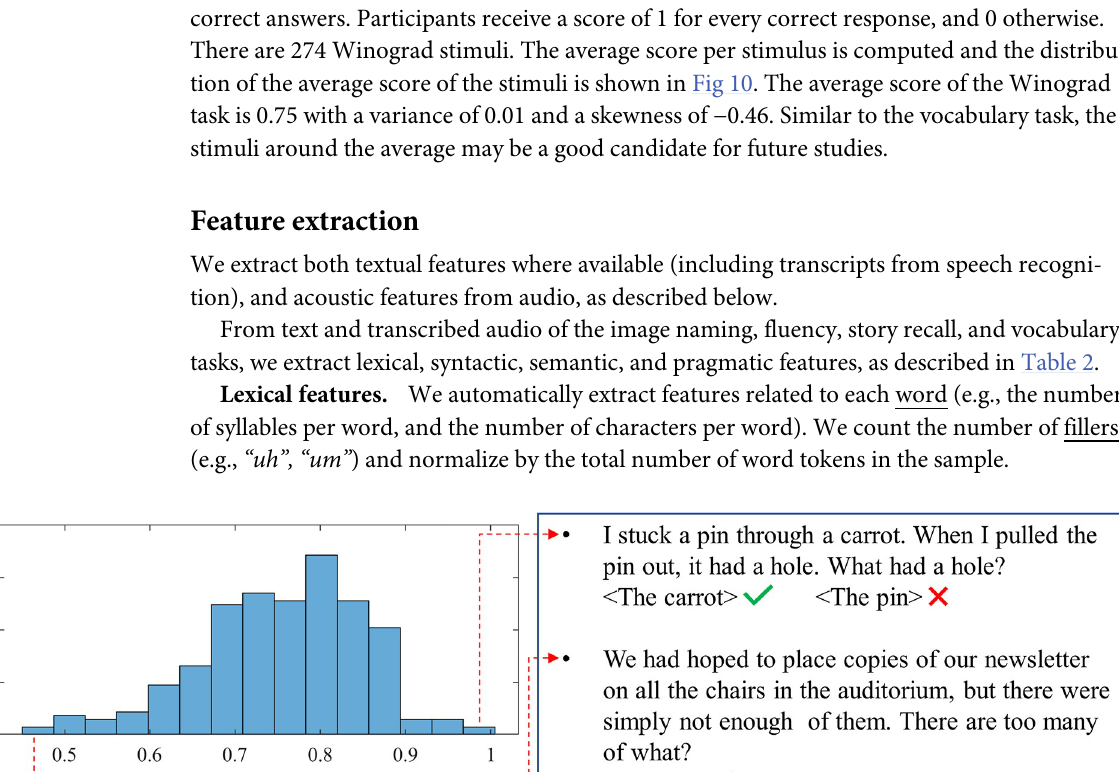
PLOS ONE | https://doi.org/10.1371/journal.pone.0212342 March 27,